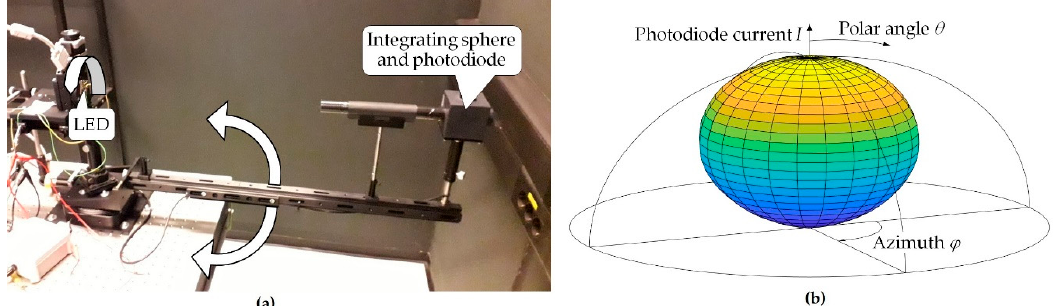
Figure 7. ( a ) Measurement setup for analyzing the angular distribution of LED radiance. ( b ) Measurements of an LED Engin LZ4-04UV00 in spherical coordinates, normalized to the peak value at θ = φ = 0. The azimuth φ describes LEDs’ rotation. The θ is the polar angle between the position of the integrating sphere and the LEDs’ main optical axis.